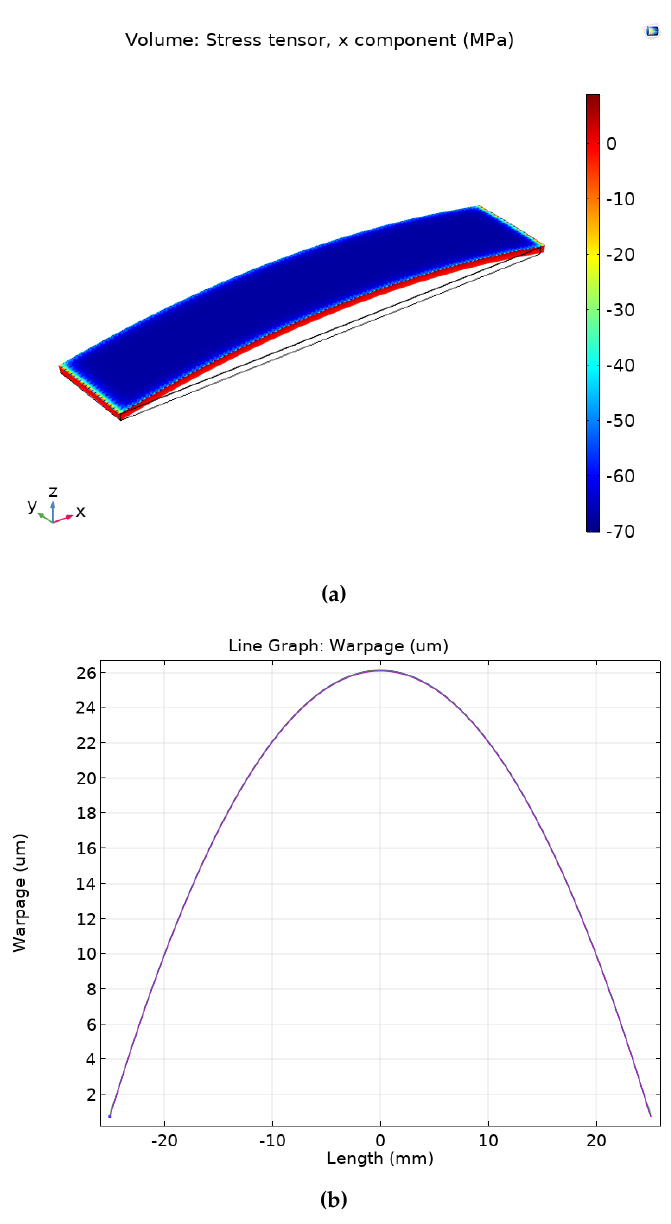
Figure 9. Direction x-stress component ( a ) and warpage on z-direction computed by FEM ( b ). Table 2. Simulation results (FEM) in terms of warpage and stress for temperature unit inside the linear heating region (50–90 ◦ C). It is reported, as reference, the analytic result coming from analytical approaches (Timoshenko and Stoney) and, as validation, the measured warpage